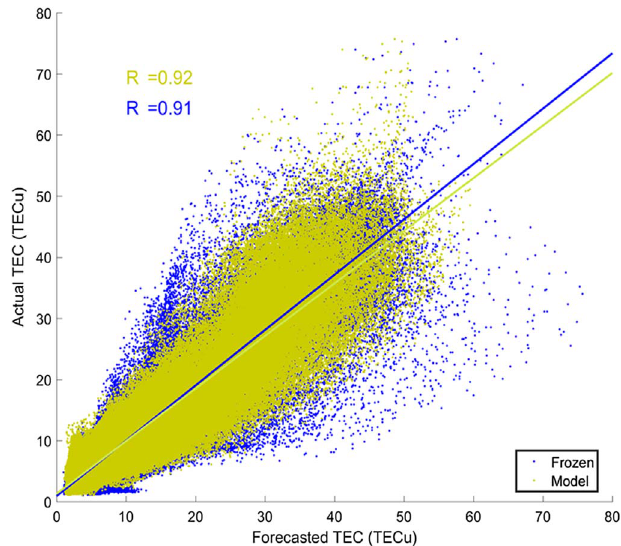
Fig. 12. Correlation between forecasted and actual TEC for the model (green) and for the frozen ionosphere assumption (blue). Solid lines indicate the corresponding linear fi t, whose R is reported on the top